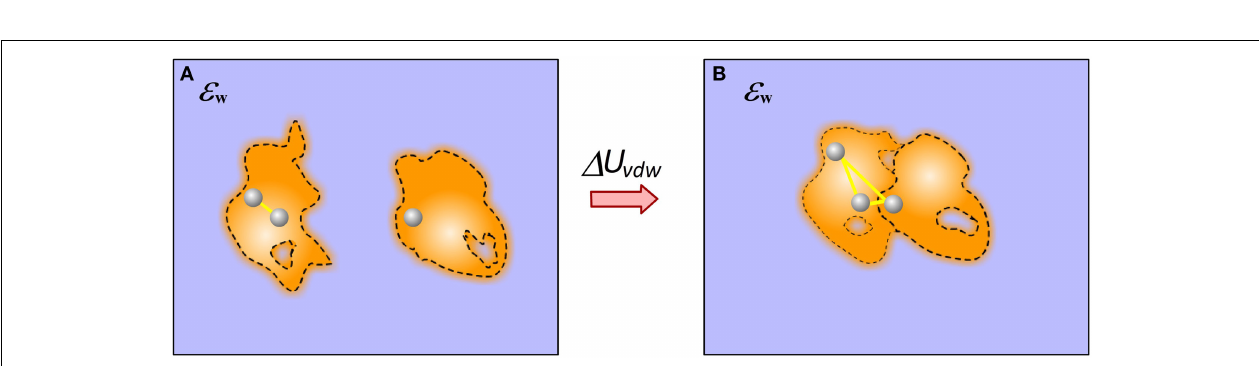
involved in favorable interactions in the complex. This causes pKa shift, the group becomes de-protonated (ionized) and the proton is released in the water phase.